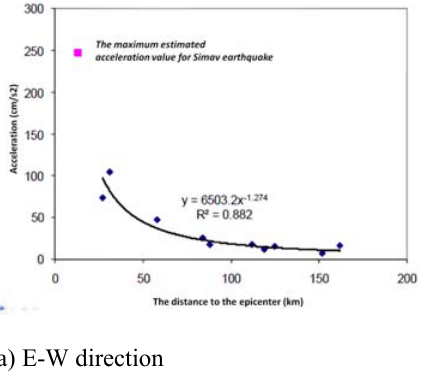
Fig. 3. Tectonics of the region and distribution of earthquake epicenters (AFAD). 4